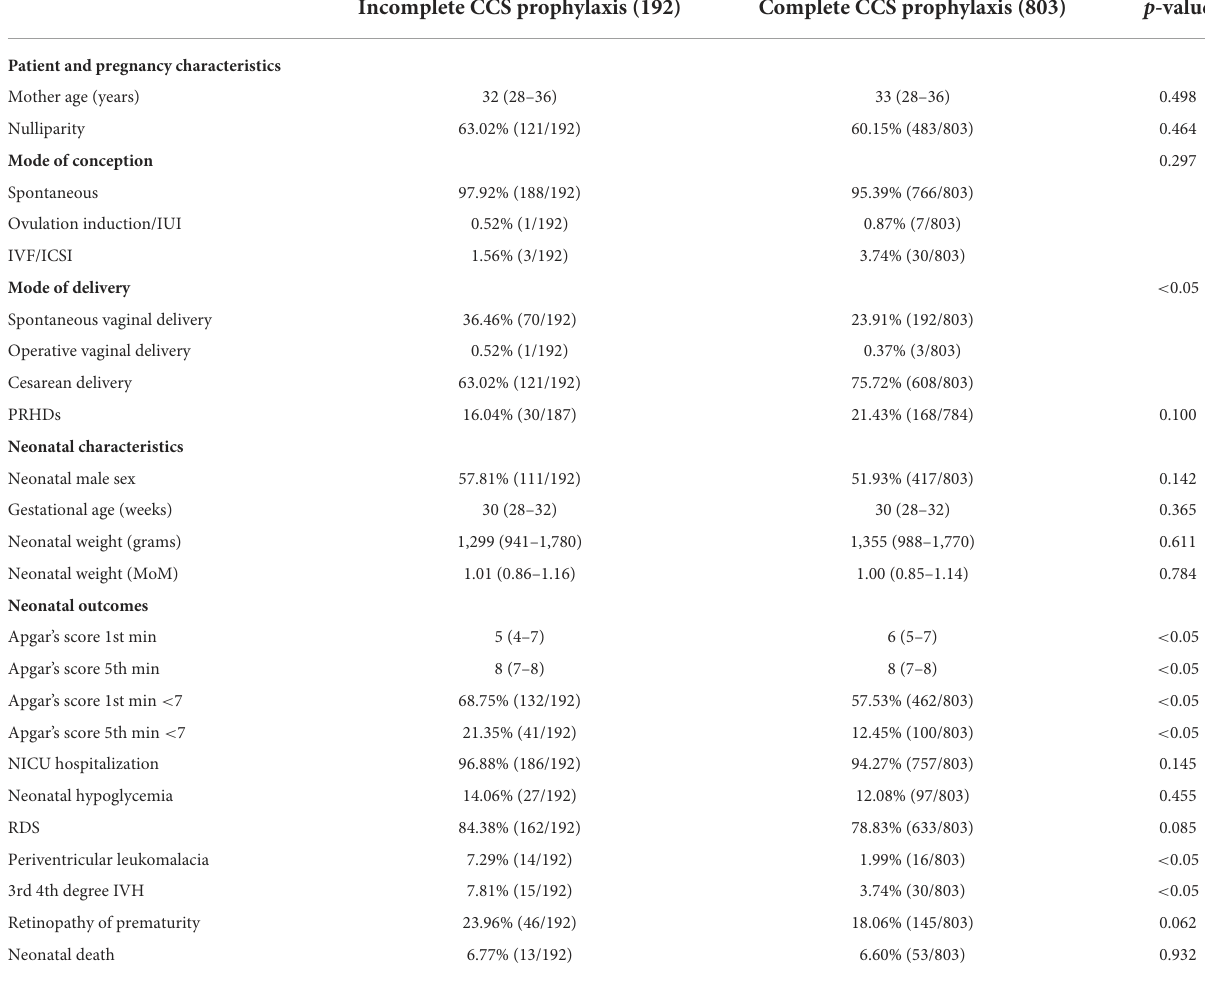
TABLE 2 Population description of singleton pregnancies stratified by complete or incomplete corticosteroid (CCS)